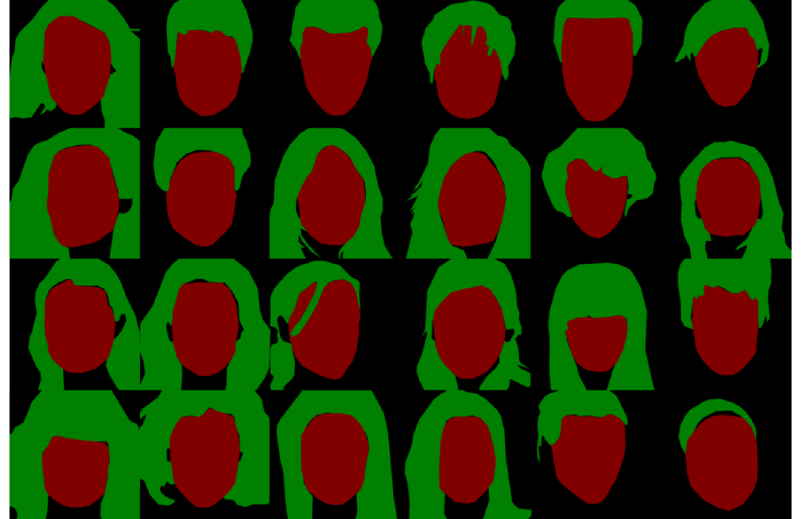
Figure 7. Label datasets created after separating hair and face using Labelme.